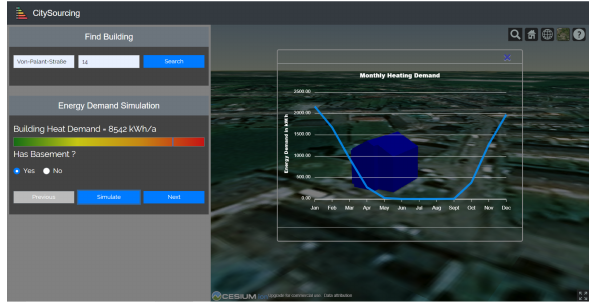
Figure 8. An example of the result of energy simulation visualized on the CitySourcing